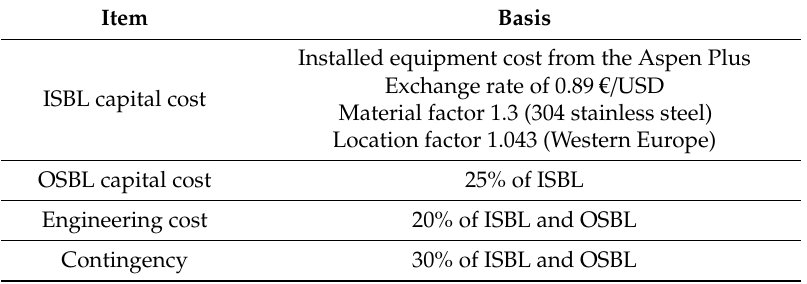
Table 1. Factorial method of capital cost estimation [16,36]. ISBL, inside battery limits; OSBL, o ff site battery